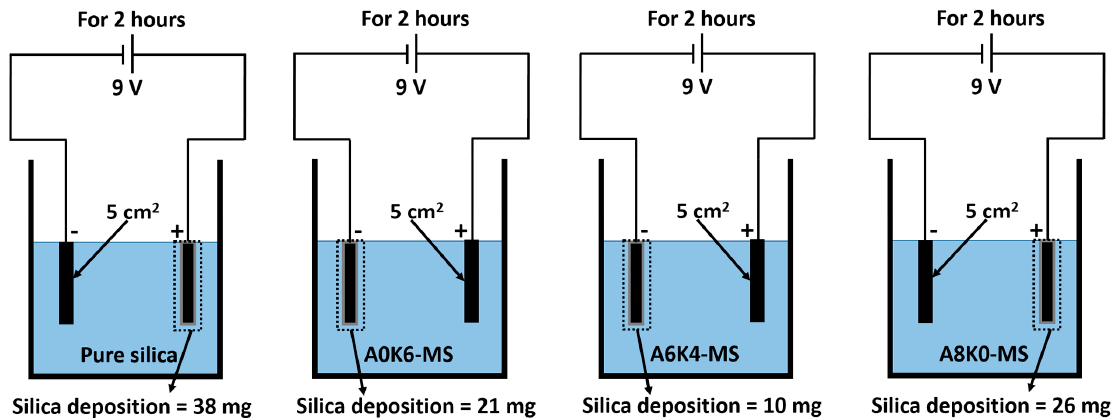
Figure 7. Schematic diagram of the silica deposition experiment.